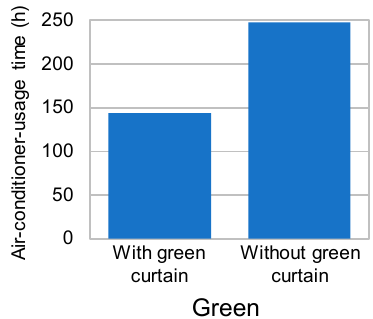
Figure 16. Air-conditioner-usage time with and without the green curtain for 48 days.